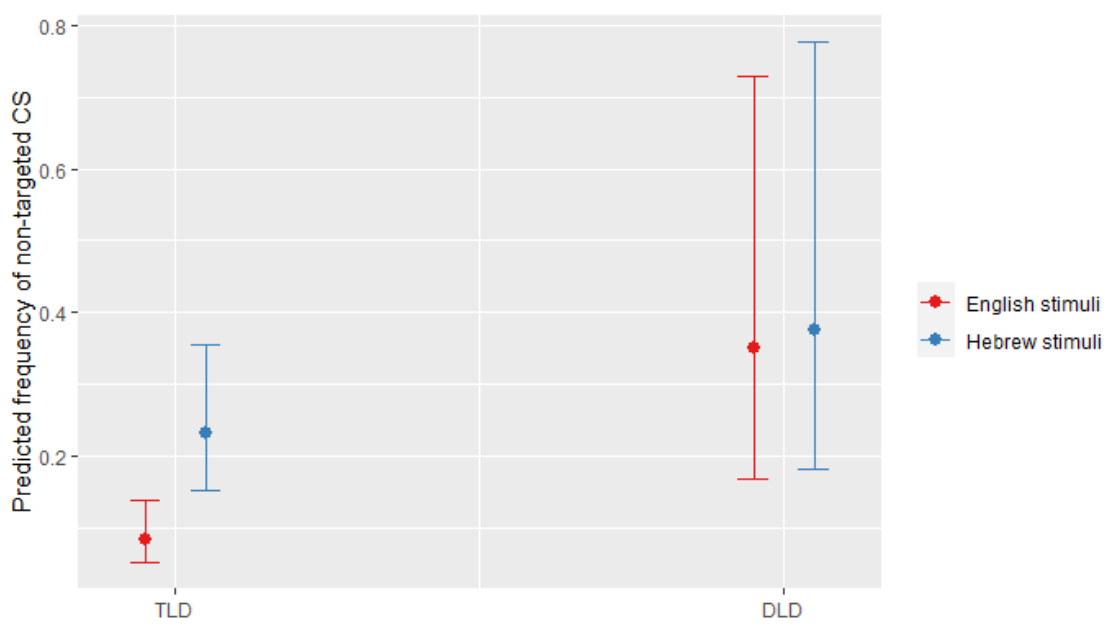
Figure 1. Predicted frequencies of non-targeted CS for the interaction of Group and Language.